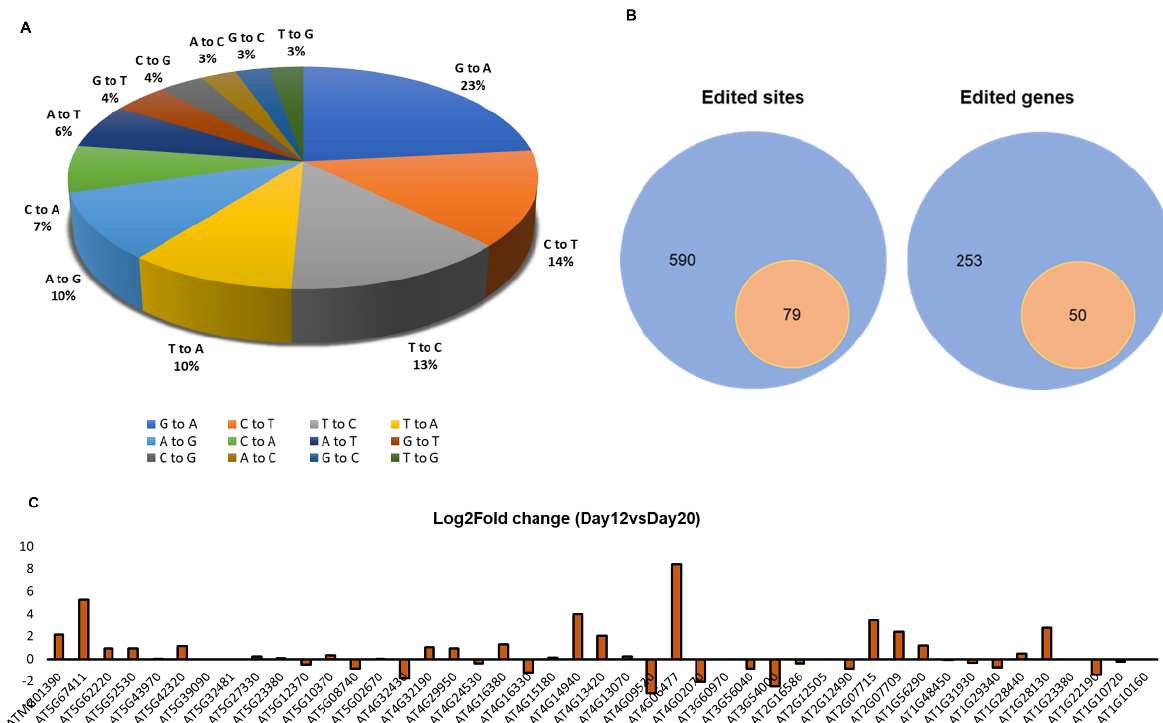
Figure 2. Analysis of single-nucleotide base conversions identified in 12-d-old Arabidopsis seedlings by RNA-seq. ( A ) Pie chart showing the percentage for genes identified with single-nucleotide base conversions. ( B ) Number of total edited sites and edited genes (blue), and number of sites and genes with U-to-C mutations (orange). ( C ) Log 2 FC values for the genes identified with U-to-C nucleotide conversion. Genes were expressed to higher levels in 12-d-old seedlings than in 20-d-old seedlings ( C ). Table 1. List of candidate U-to-C RNA editing sites detected in Arabidopsis seedlings at different developmental stages.